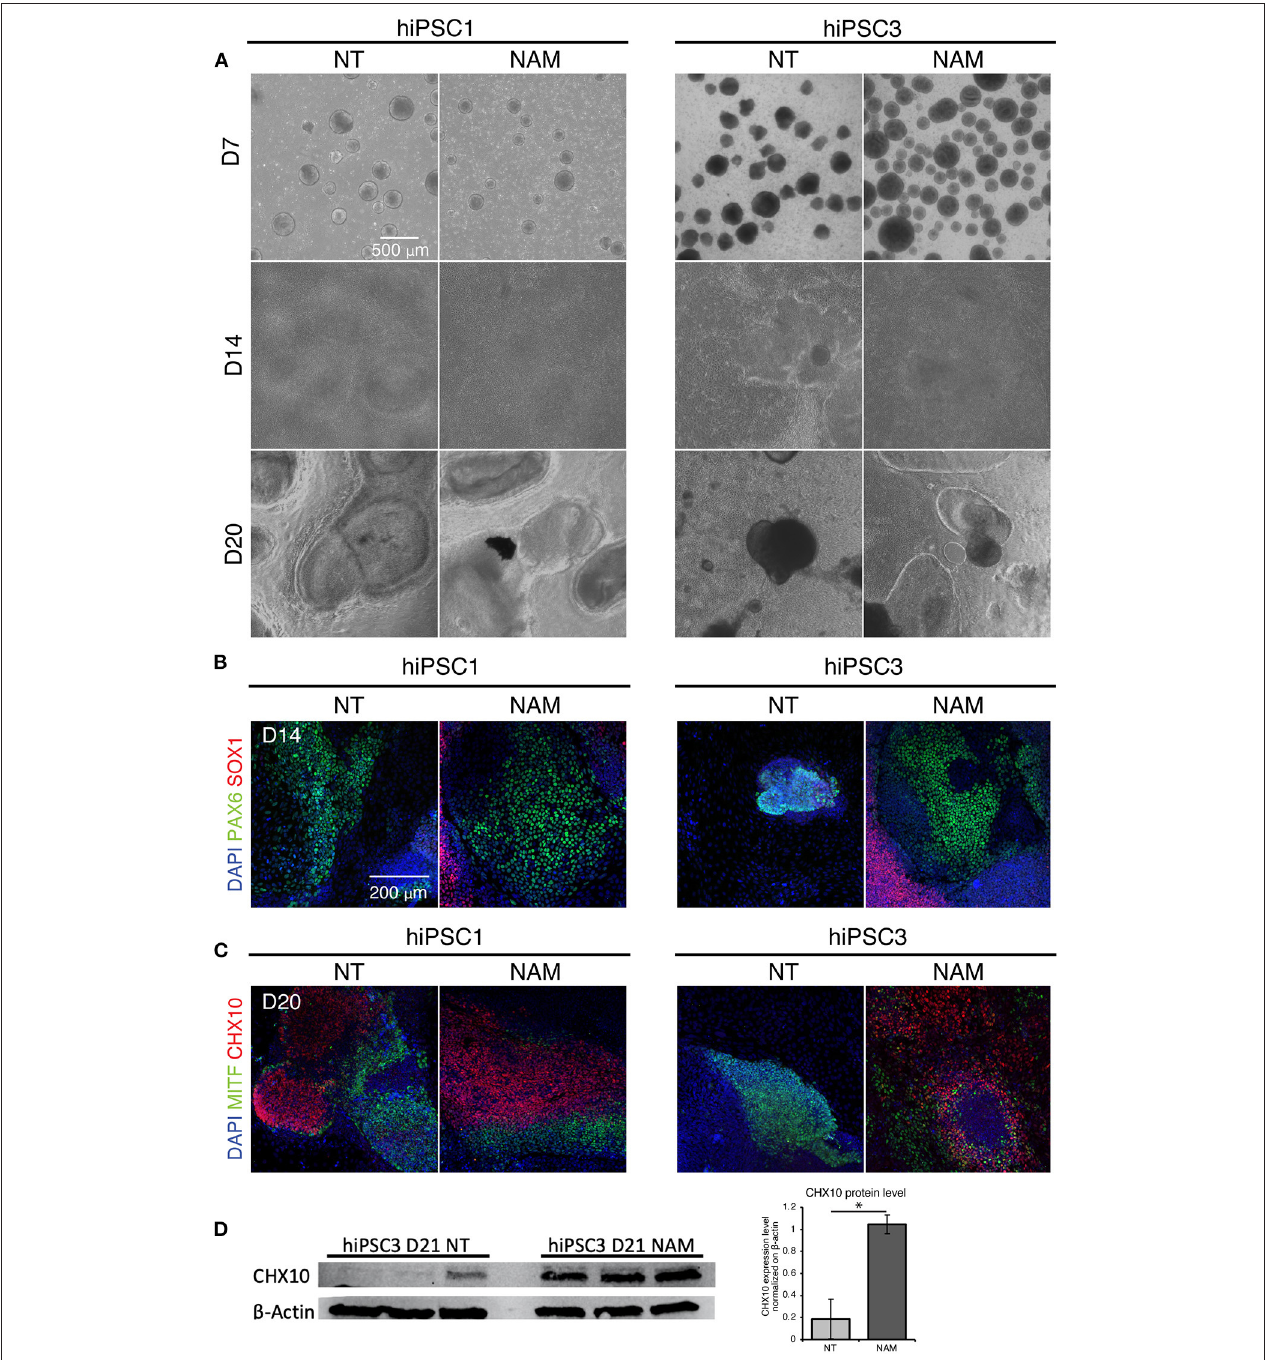
FIGURE 3 | Nicotinamide treatment improves EB formation and eye field progenitor differentiation and spreading. (A) Bright field images of non-treated (NT) and Nicotinamide-treated cultures at differentiation day 7, 14, 20. (B) Immunostaining of neuroectodermal makers (PAX6/SOX 1 ). (C) Retinal markers CHX10 and MITF showing neural retinal progenitor cells and prospective pigmented epithelial cells, respectively. (D) Western blot analysis (left) and quantification (right) of the expression of the neural retina progenitor marker CHX10 in NT and NAM-treated hiPSC3 cultures at D21. 3 independent differentiation batches were quantified. * p < 0.05.